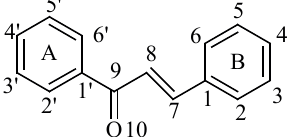
Figure 1. The molecular structure and atomic numbering of trans-